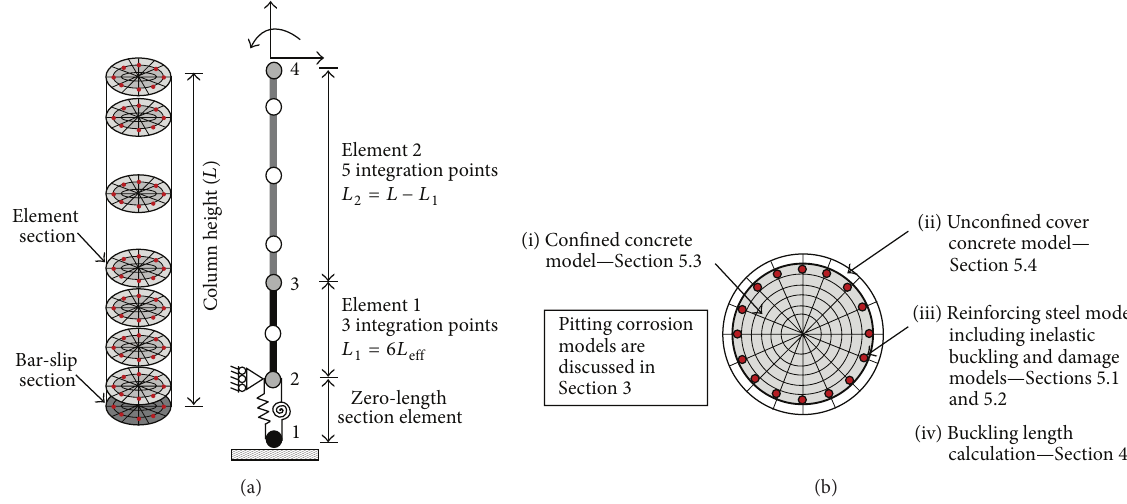
Figure 1: Proposed finite element model: (a) force-based nonlinear beam-column arrangement; (b) fibre section.